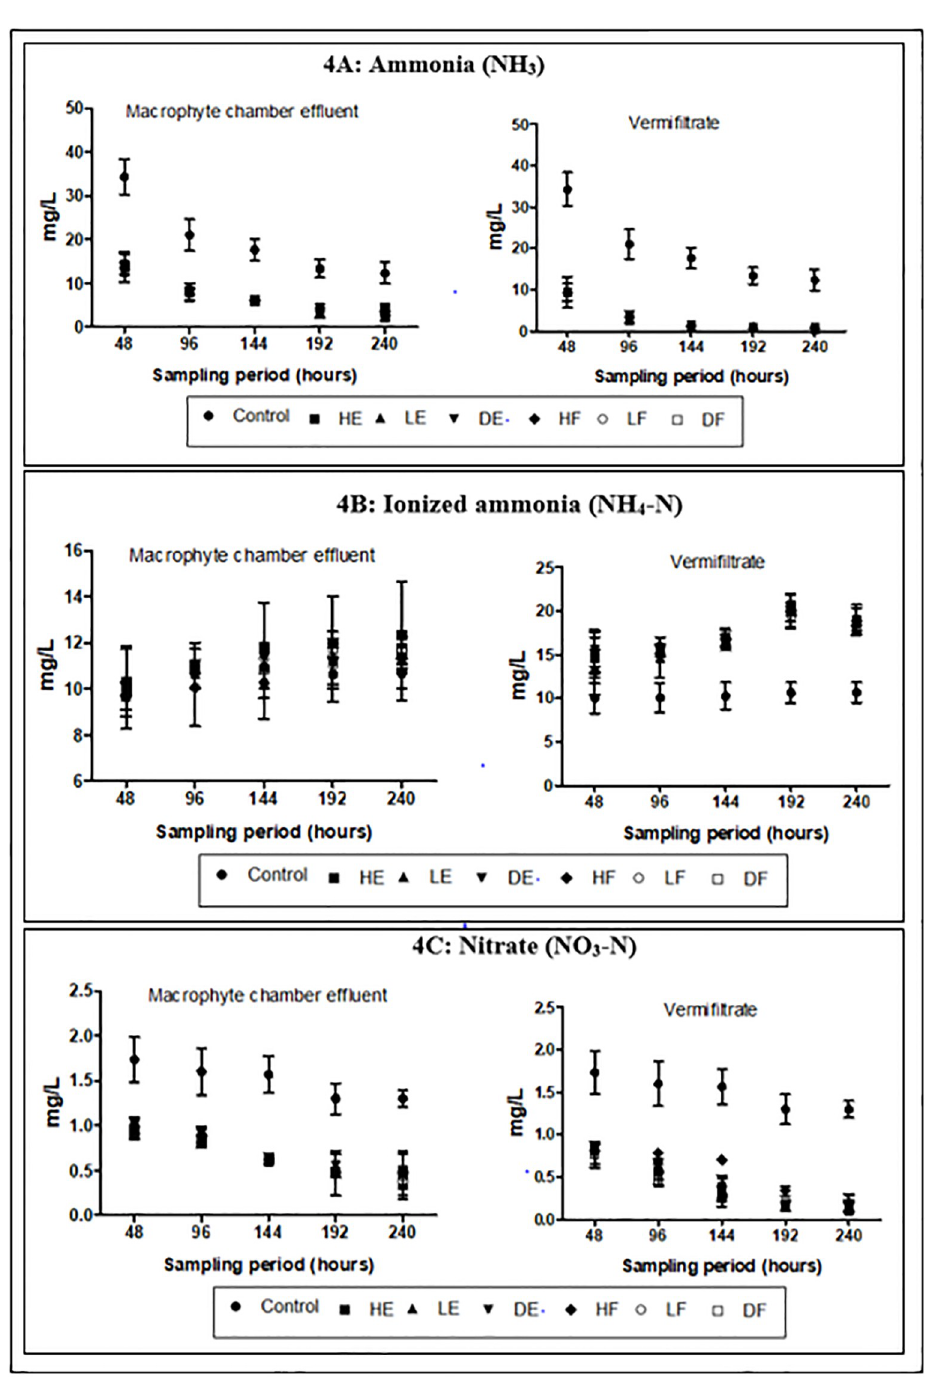
Fig 4. Physicochemical characteristics of effluent (A) NH 3 (B) NH 4 -N (C) NO 3 -N.